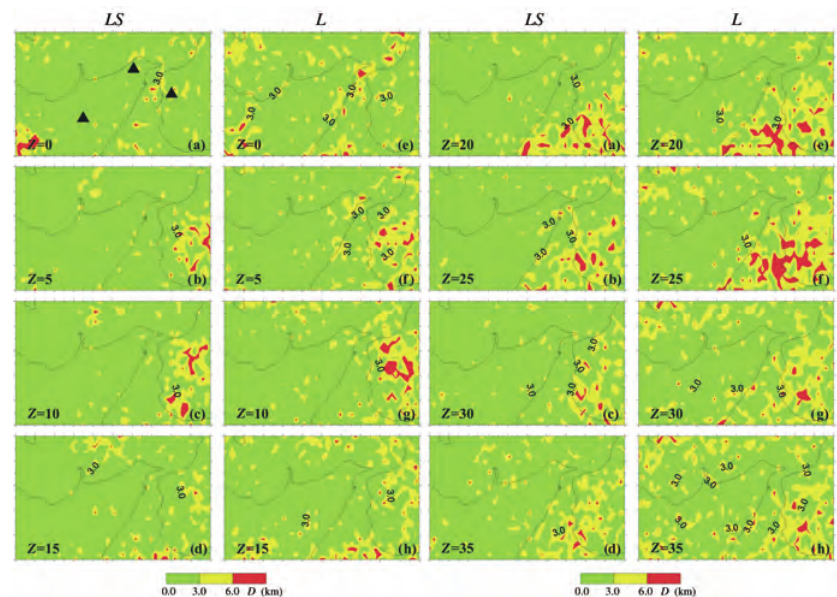
Fig. 7. Comparison of D -parameter horizontal distributions at different depths obtained by synthetic tests with the LS integrated network (left panels) and the L land-based network (right panels). The standard deviation of the random noise perturbation of synthetic arrival times is 0.3 s.